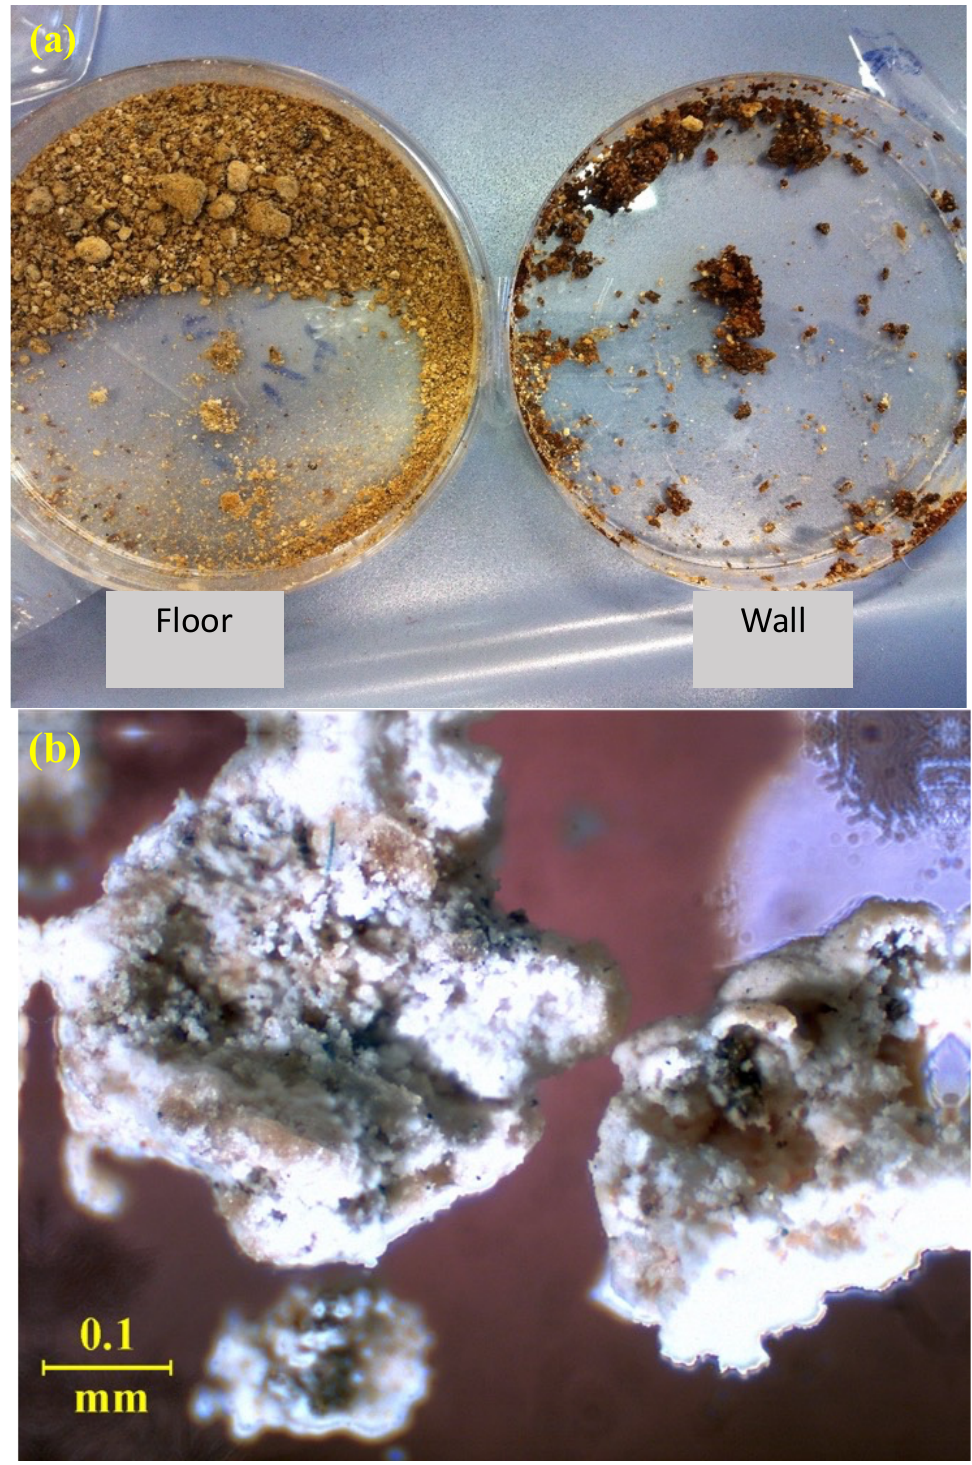
Figure 3. ( a ) Photo of the samples of the degradation product of both the floor and the wall (glass Petri plate 80 mm); ( b ) photo of the degradation product of the pavimental mosaic taken by the optical microscope (1000× magnification; width focusing 25 mm, 2 mm increments; 6 V/20 W halogen light).